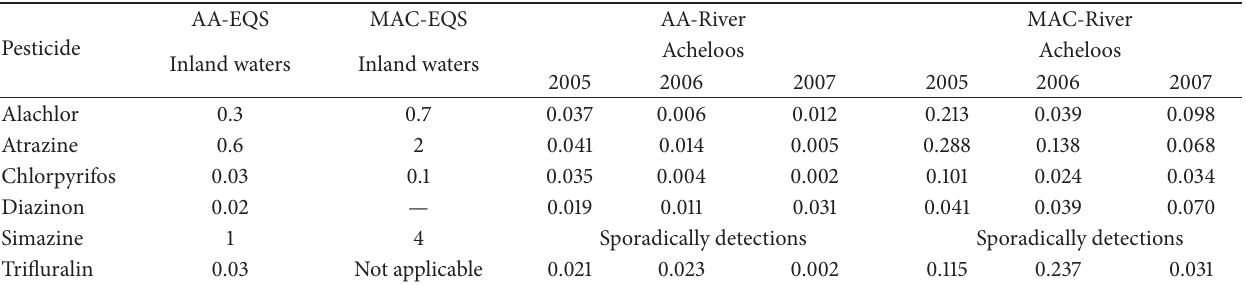
Table 7: Compliance of detected concentrations with environmental quality standards (EQS) ( 𝜇 g L − 1 ) established for the priority pesticides monitored in the present